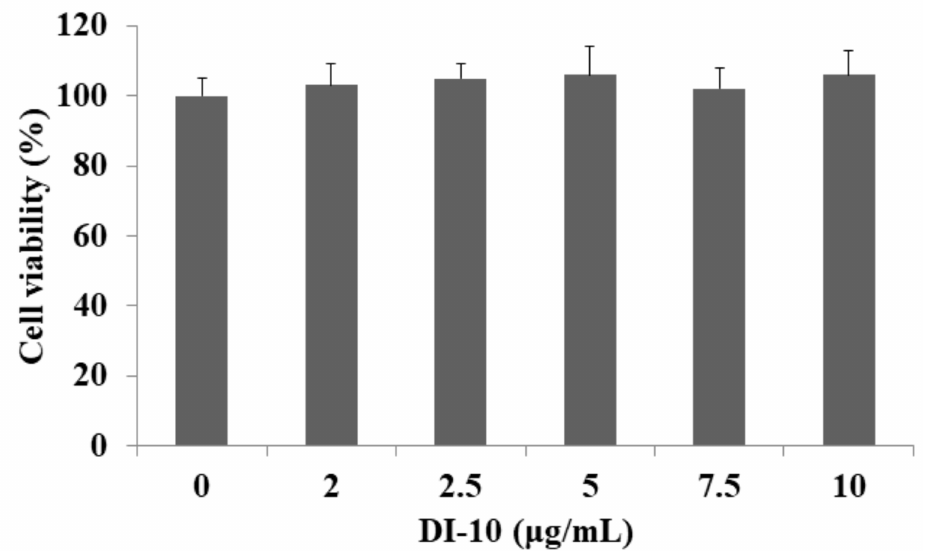
Figure 1. Effect of decapeptide DI-10 on myoblast cell viability. C1C12 cells were treated with different concentration of